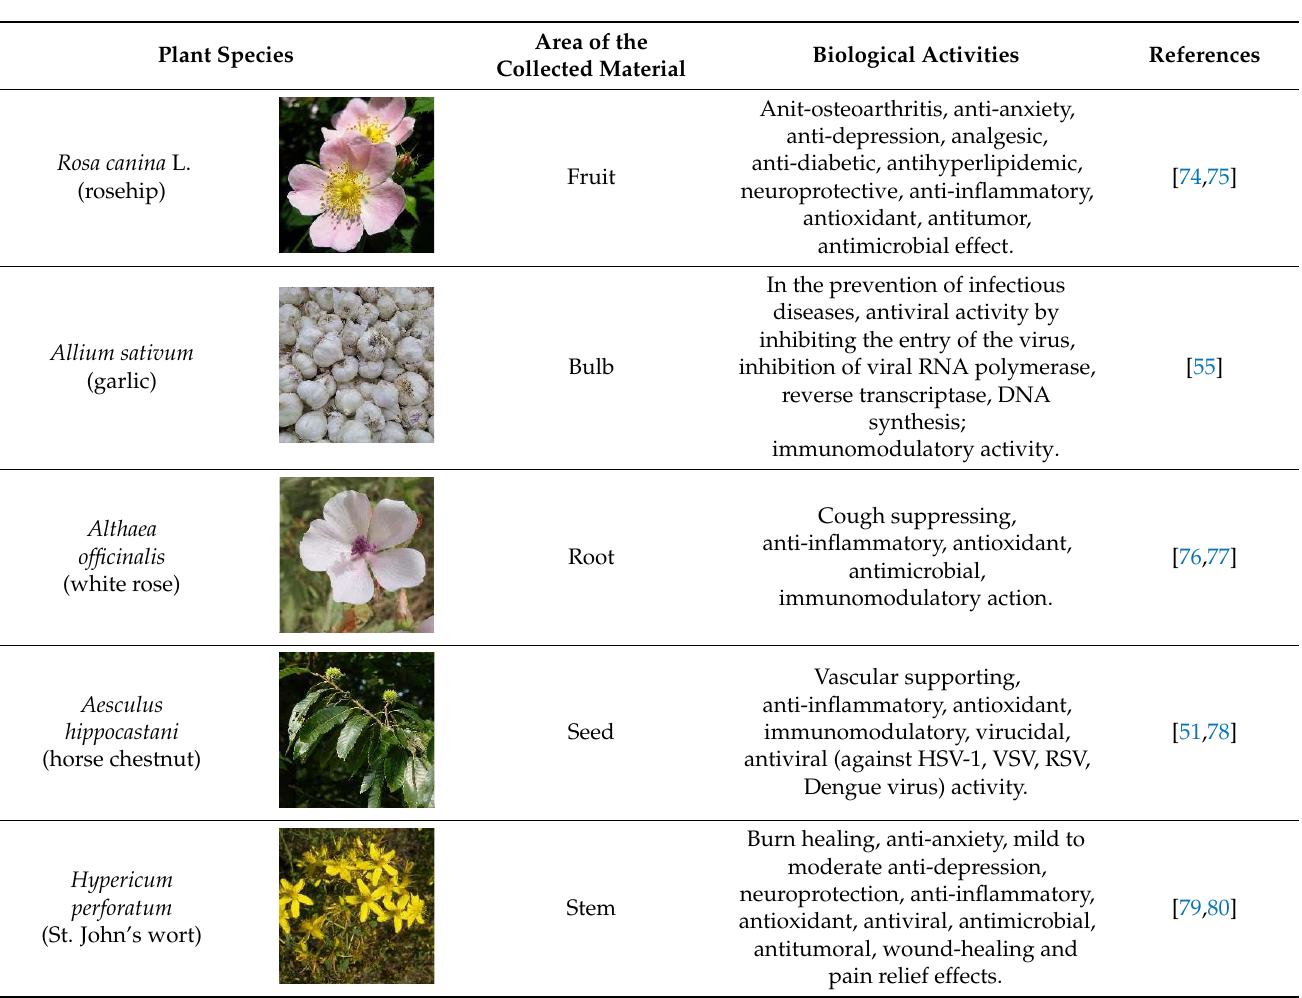
discs. The diameter of the inhibition zone (mm) was an indicator for the degree of